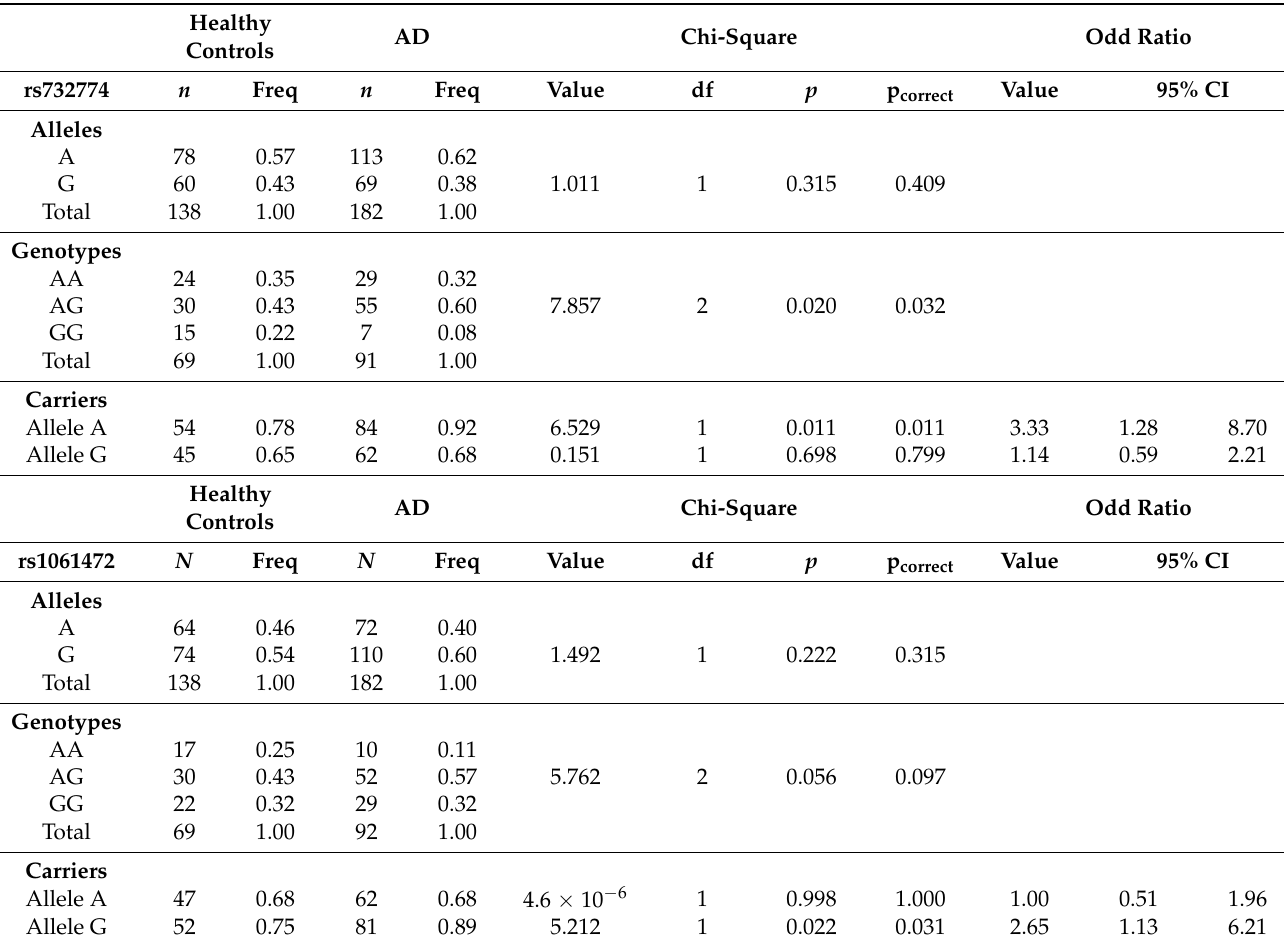
Table 3. Genetic characteristics of the investigated AD patients and HC